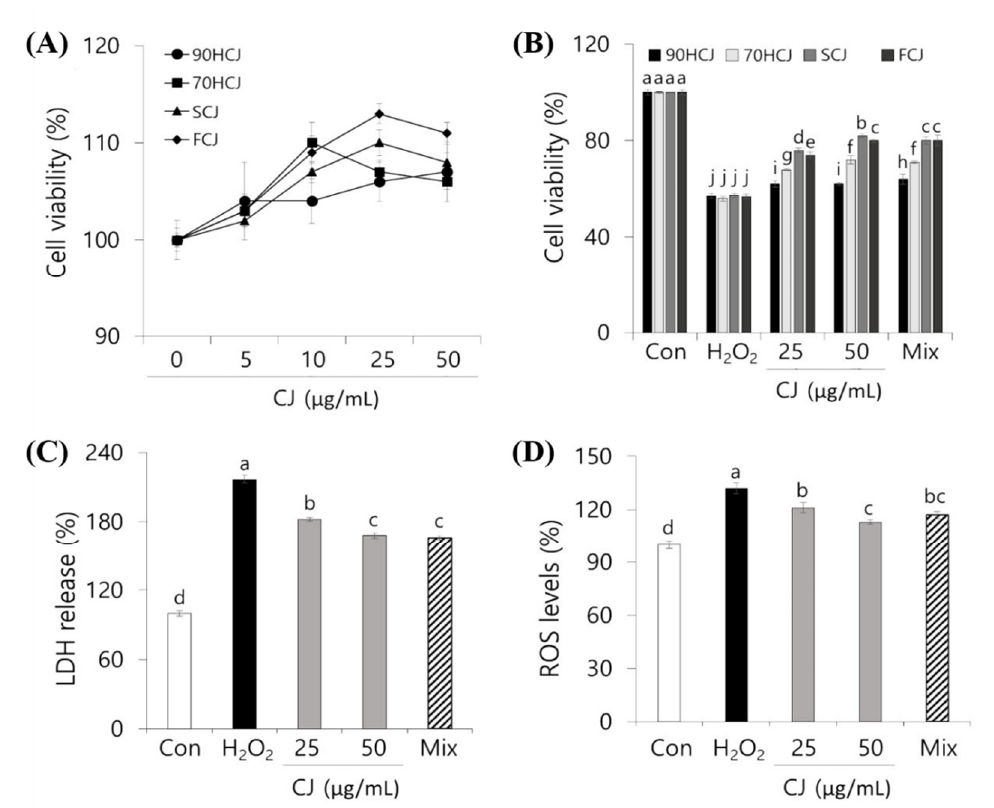
Figure 3. Protective effect of CJ on PC12 cell against oxidative stress. ( A ) Effect of CJ extract on viability of PC12 cells by MTT assay and ( B ) Effect of CJ extract on the viability of PC12 cells that were induced oxidizing damage with H 2 O 2 ( C ) Effect of CJ extract on H 2 O 2 -induced membrane damage in PC12 cells. ( D ) Effect of CJ extract on ROS generation in PC 12 cells damaged by H 2 O 2 . The values are mean ± SD of three individual experimental results (n = 3). (B) The letters presented above the same color bars represent statistically significant differences ( p < 0.05 ). (C) and (D) The letters presented above the bars represent statistically significant differences ( p < 0.05 ). 90HCJ: hot-air-dried C. japonicum at 90 °C, 70HCJ: hot-air-dried C. japonicum at 70 °C, SCJ: shade-dried C. japonicum and FCJ: freeze-dried C. japonicum.